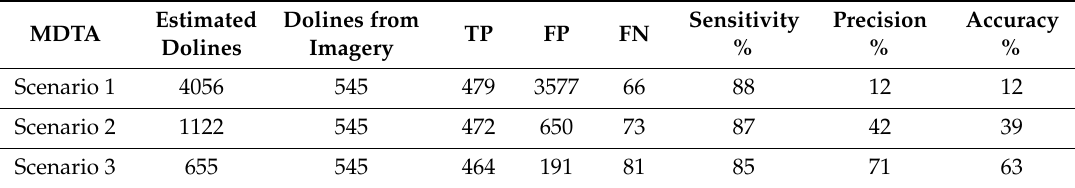
Table 2. Summary of the three MDTA